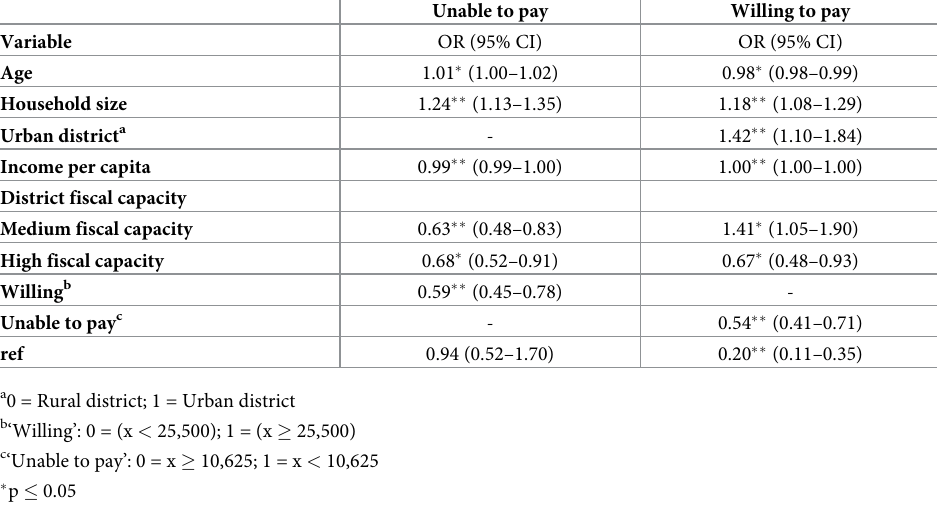
Table 7. Determinants of being unable to pay, and willing to pay (i.e., ATP lies below 10,625, WTP lies above